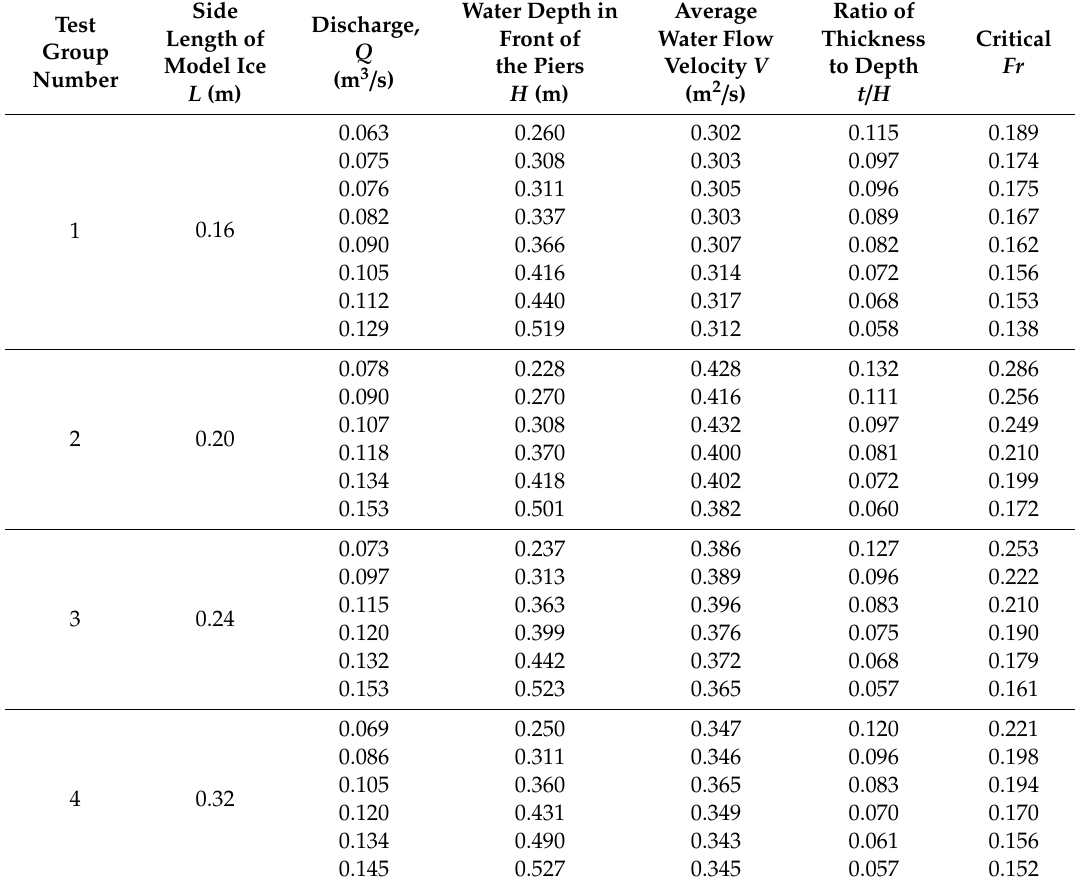
Table A2. At the same side length of ice, the critical Fr at di ff erent discharges.